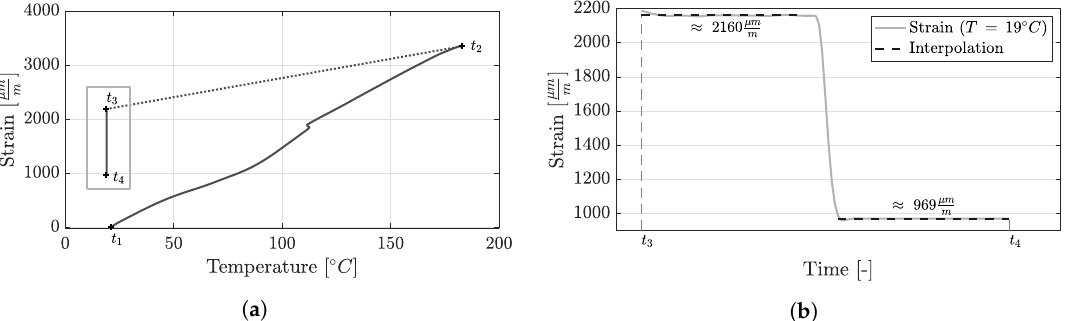
Figure 15. Strain gauge recordings during manufacturing and demolding of the instrumented asymmetric specimen. Strain readings start at t 1 and finish at t 4 . ( a ) Strains over temperature during cure; ( b ) Strains over time during